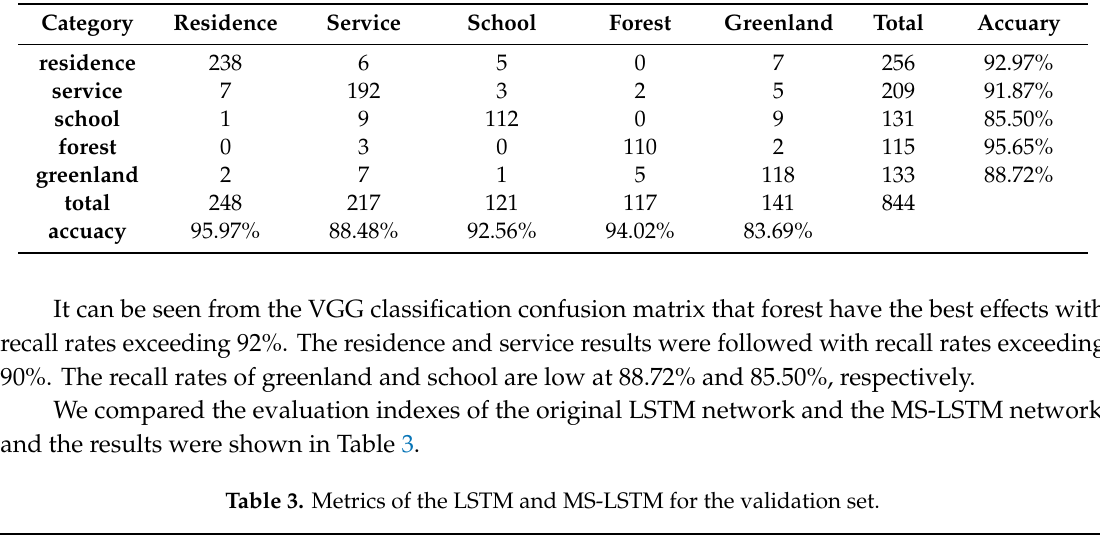
Table 2. VGG classification confusion matrix.